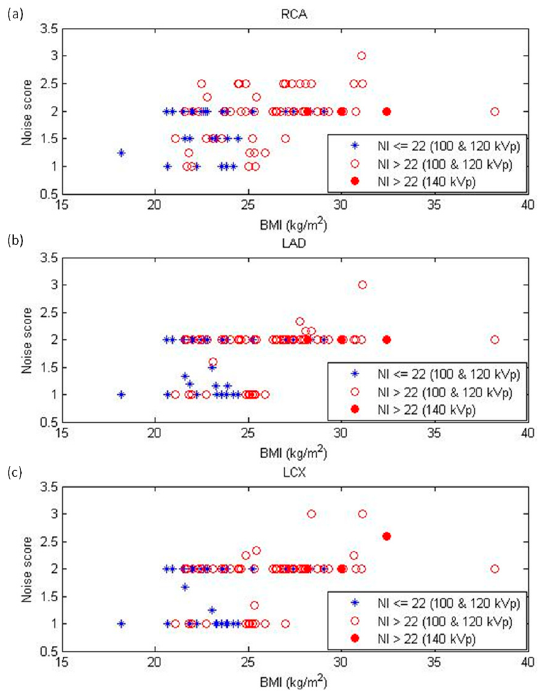
Figure 4. Subjective noise score on a per-vessel basis for the ( a ) right coronary artery (RCA), ( b ) left anterior descending artery (LAD), and ( c ) left circumflex artery (LCX) as functions of body mass index (BMI). NI = noise index.